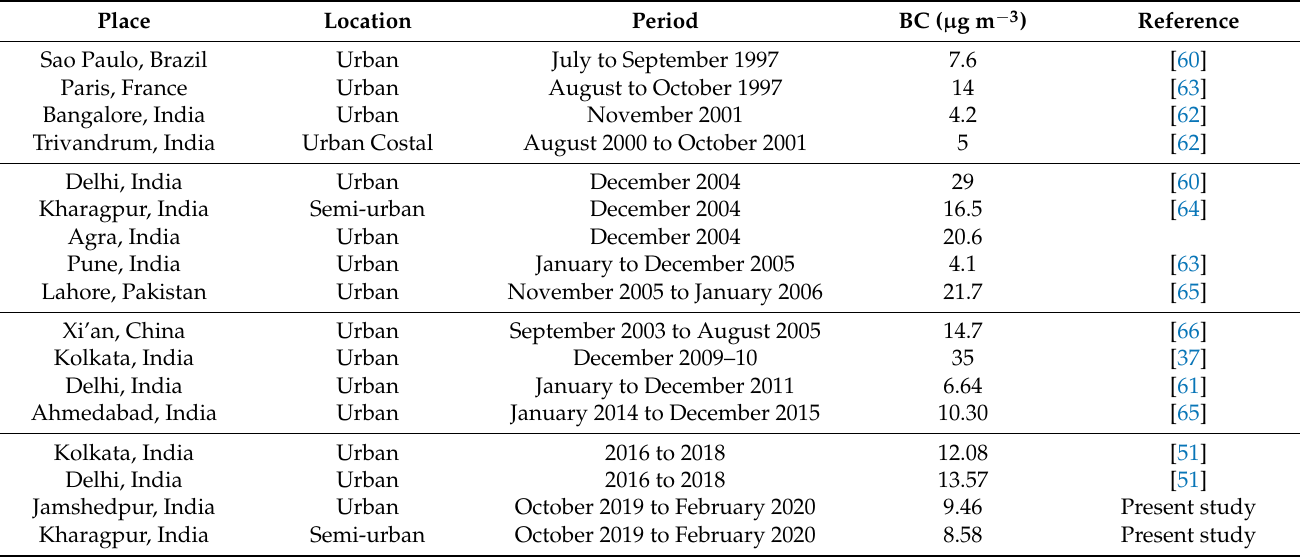
Table 2. Comparison of BC mass concentration ( µ g m − 3 ) measured at various locations in India and other